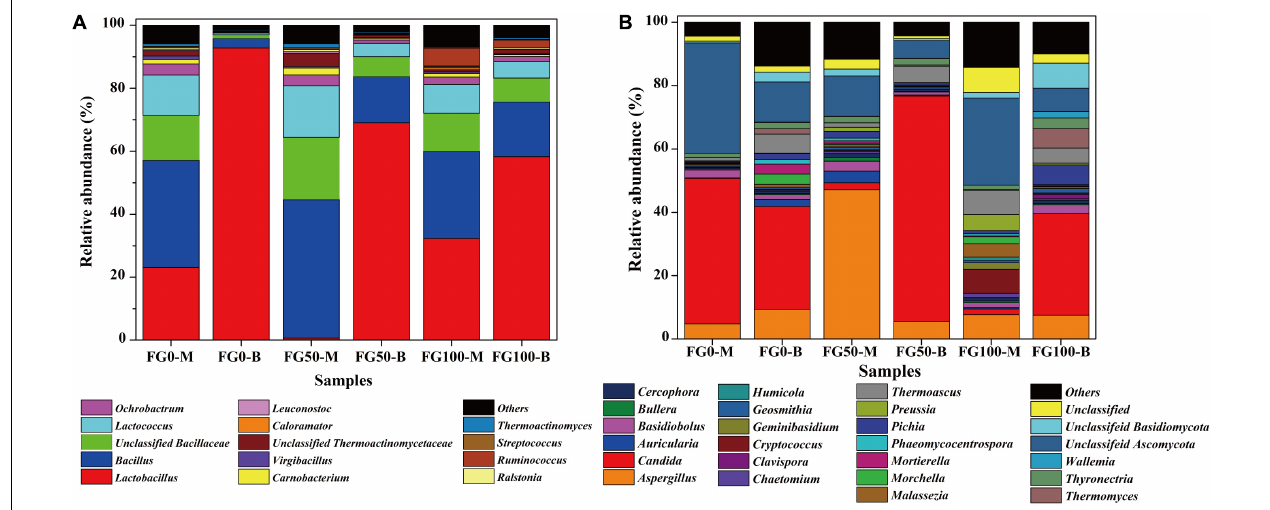
FIGURE 4 | Relative abundance of prokaryotic (A) and eukaryotic (B) communities in FG at genus level.